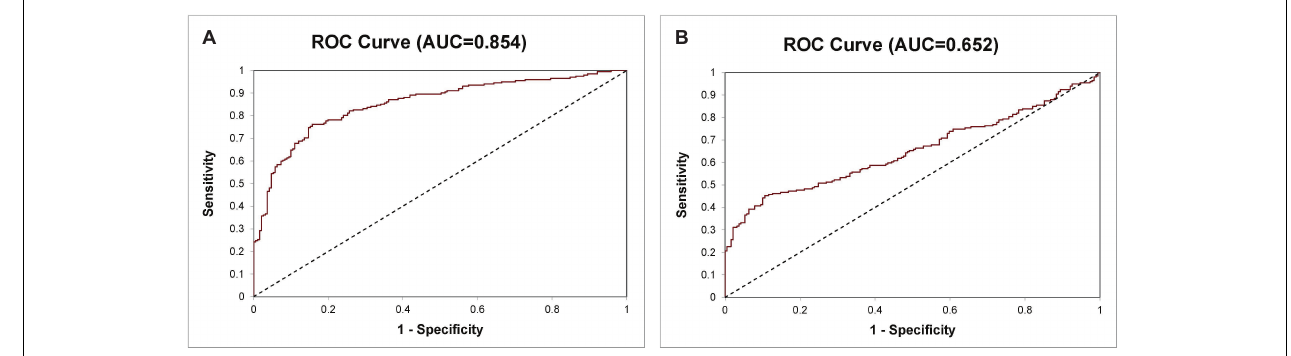
FIGURE 4 | ROC curve of the 14-Gene Panel and PSA for diagnosis of PCa and benign prostate in the prospective urine cohort. ROC curve of the 14-Gene Panel (A) and PSA (B)